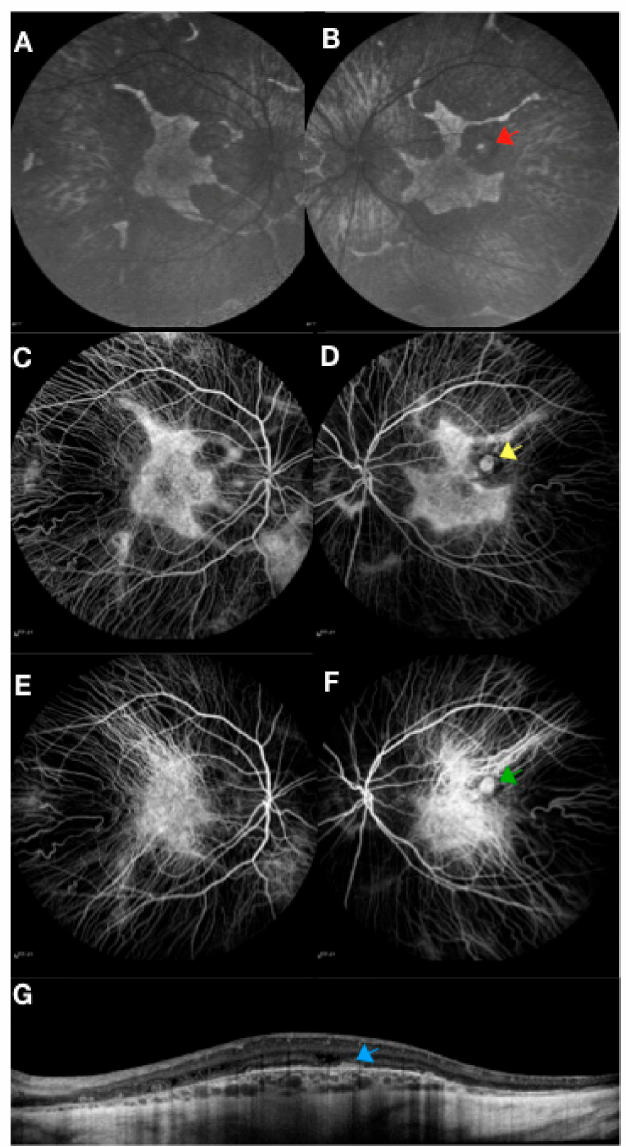
Figure 2. Retinal imaging in a choroideremia patient showing an area of scaring from an old choroidal neovascular membrane in the left eye. Fundus autofluorescence ( A , B ), fluorescein angiography ( C , D ), indocyanine green angiography ( E , F ) and spectral domain optical coherence tomography ( G ) with arrows marking the old scar. Imaging was performed with Heidelberg Spectralis, Heidelberg,